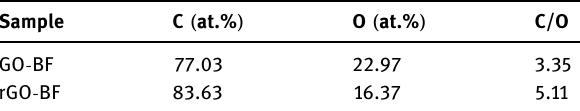
Table 1: Atomic weight percentages of C 1s and O 1s spectra of the GO - coated BF and graphene - coated BF obtained through XPS Sample